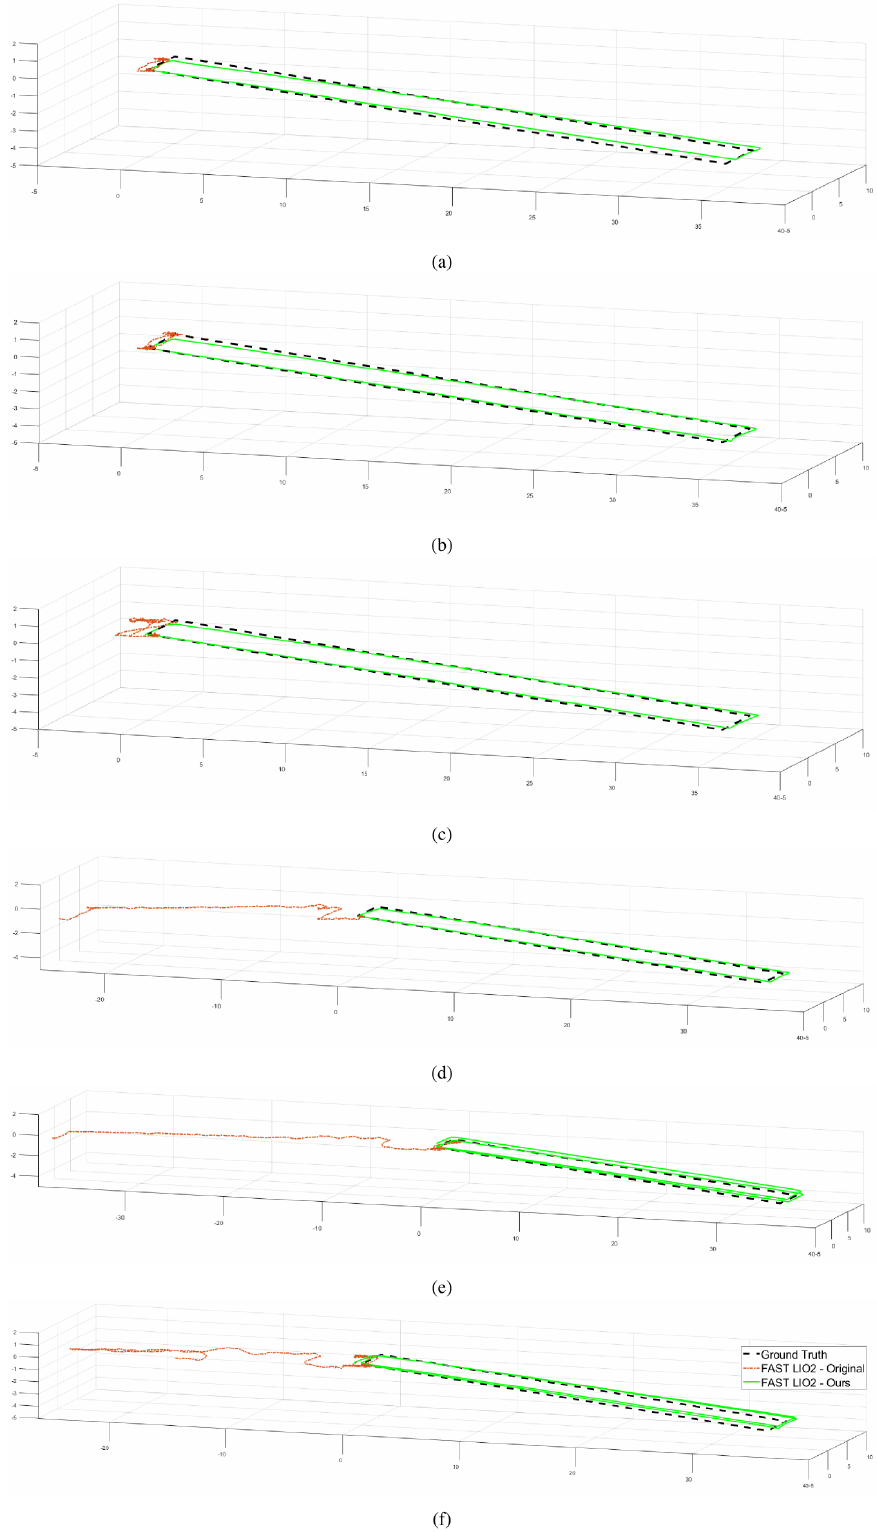
Figure 8. Estimated trajectory path comparison between the original and improved FAST-LIO2 in the inclined terrain section of the tunnel environment: ( a – d ) single-loop runs, and ( e , f ) double-loop